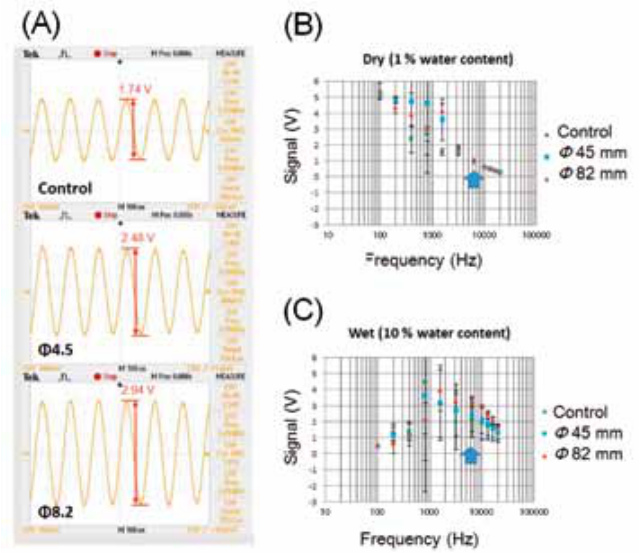
Fig. 2 - Detection of sound signals propagated in the sand layer with and without sweet potato tuberous toots. (A) Typical raw re- cords of signal modulated at ca . 6.4 kHz (6.386-6.413 kHz). Changes in signal intensity (voltage changes between the peaks and valleys of the waves) were monitored. Relationship be- tween the frequency and yield of sound signal in the beds of dry sand (B; water content, ca . 1%) and wet sand (C; water content, ca . 10%) were compared. Arrows in (B) and (C) indicate signal yields at 6.4 kHz. Error bars, S.D. (n=